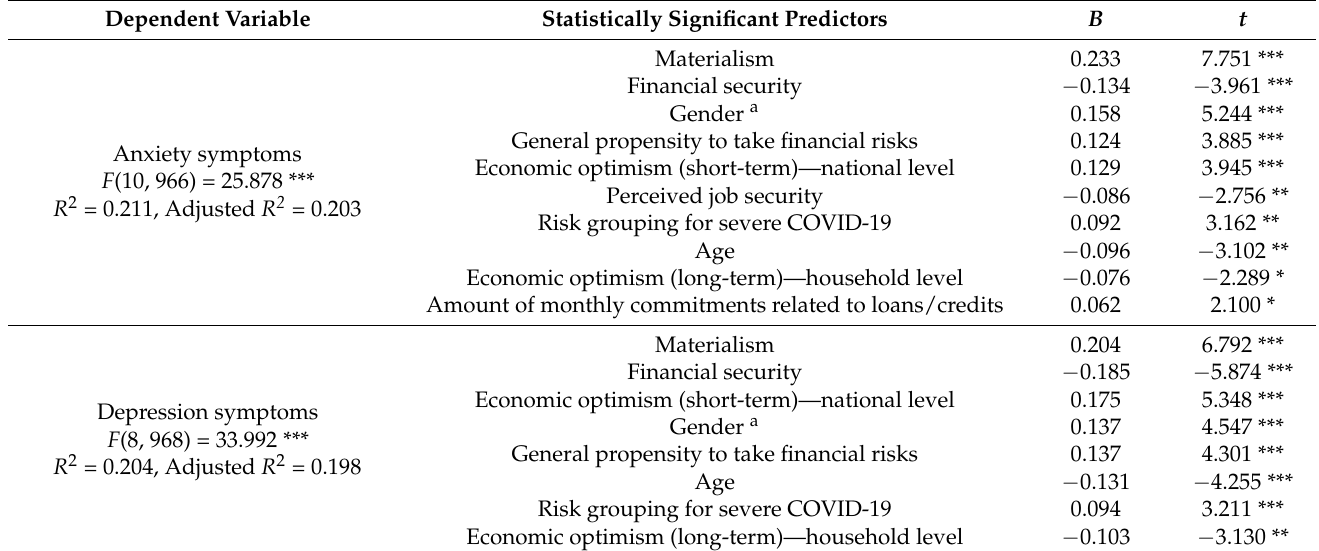
Table 3. The results of two stepwise regression analyses predicting psychological distress from individual